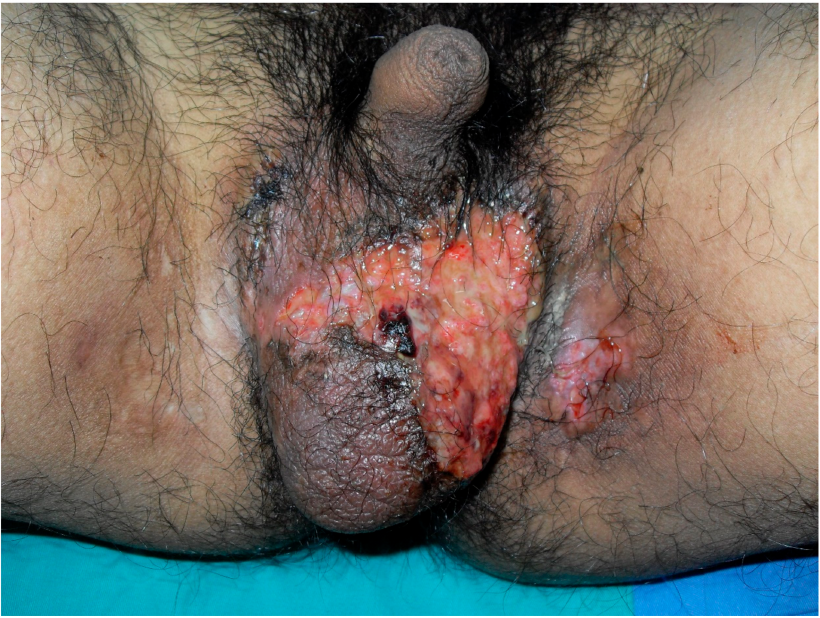
Figure 1. A painful destructive ulcer with an irregular margin and erythematous edges on the anterior scrotal